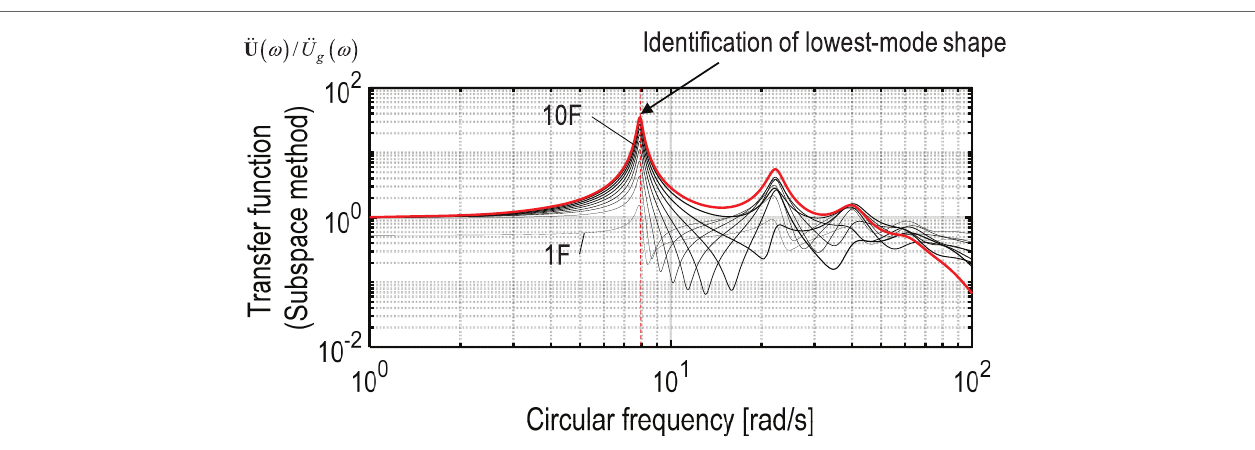
FIGURE 7 | Identified transfer function for horizontal